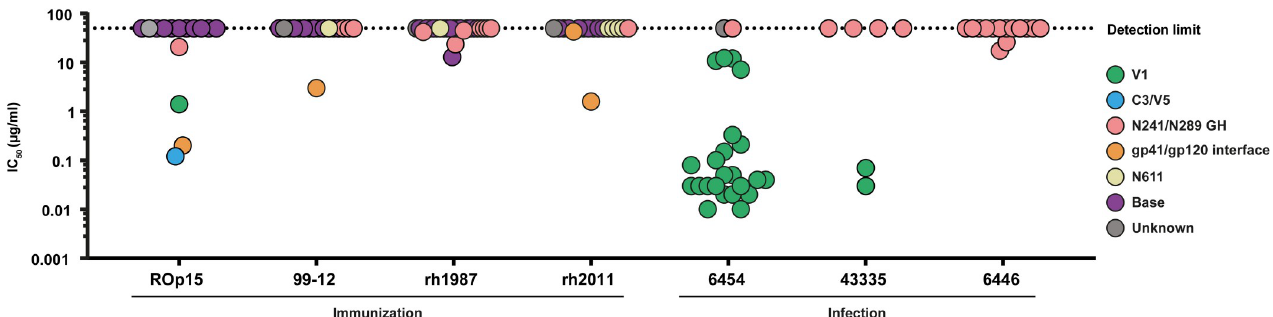
Fig 4. Potency and epitope specificities of isolated mAbs. Half maximal inhibitory concentration (IC 50 ) for every mAb isolated from the different NHPs. Epitopes targeted by these mAbs are indicated in different colors showing the relationship between neutralization potency and the various epitopes. Antibodies that have a potency higher than 50 μ g/mL are classified as non-neutralizing. We also included the information from mAbs that were previously isolated from two BG505 SOSIP.664-immunized NHPs (rh1987 and rh2011).